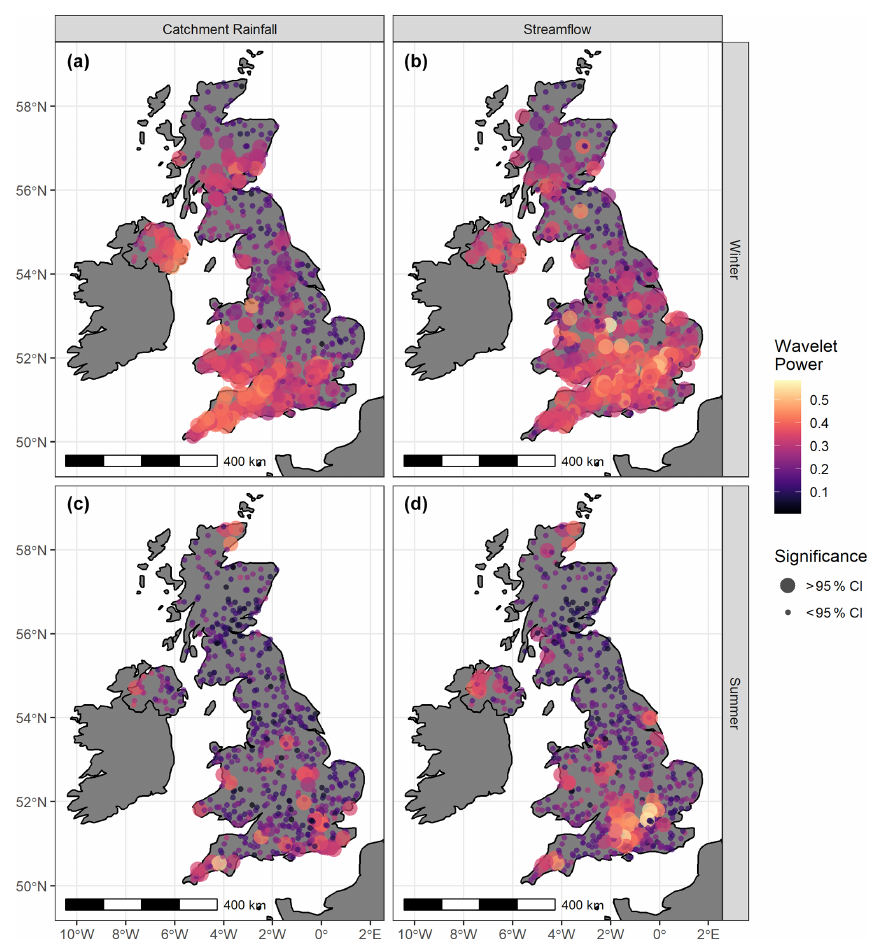
Figure 5. Spatial distribution of P7 wavelet power and significance in catchment rainfall and streamflow for winter- and summer-averaged data